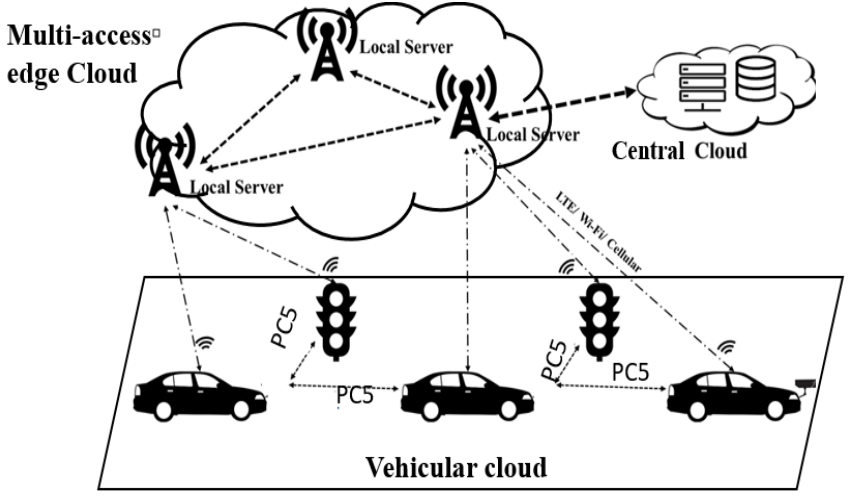
Figure 1. High level of cloud-based vehicular application